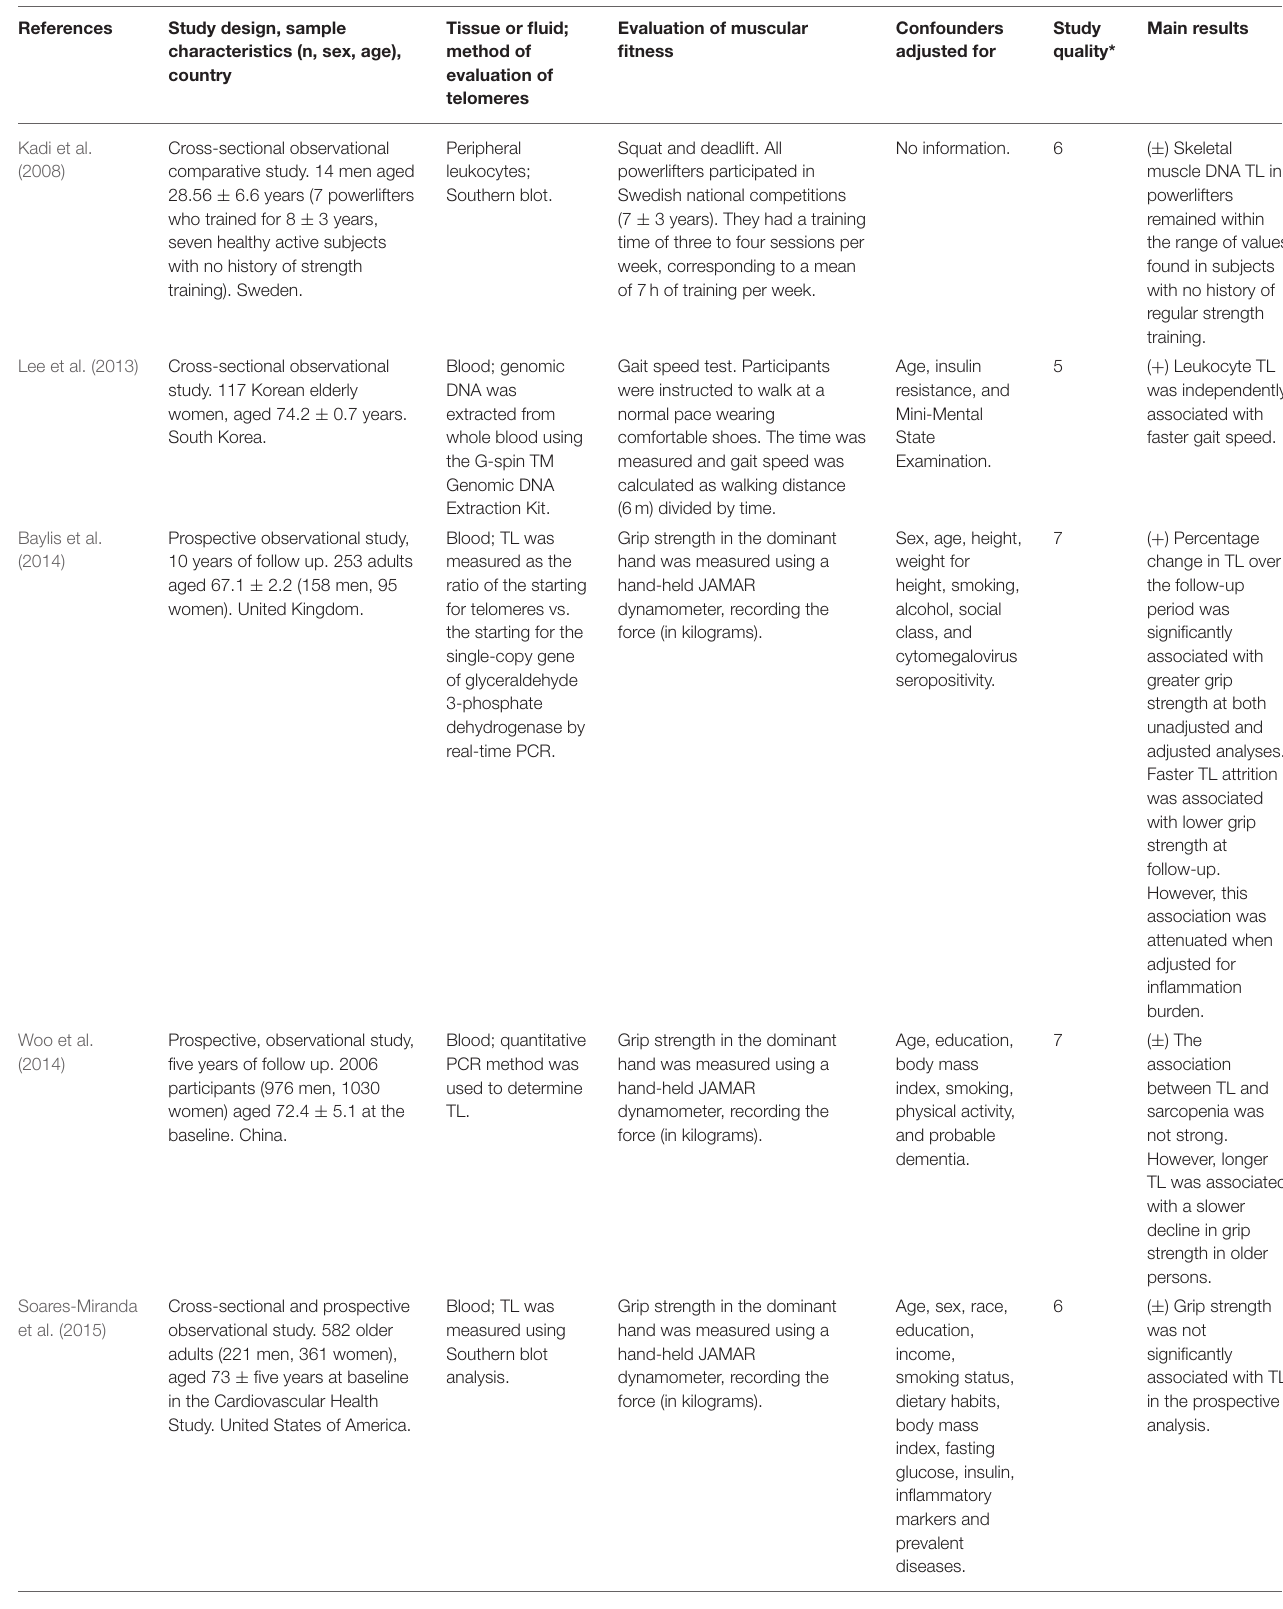
TABLE 1 | Characteristics and main results of studies